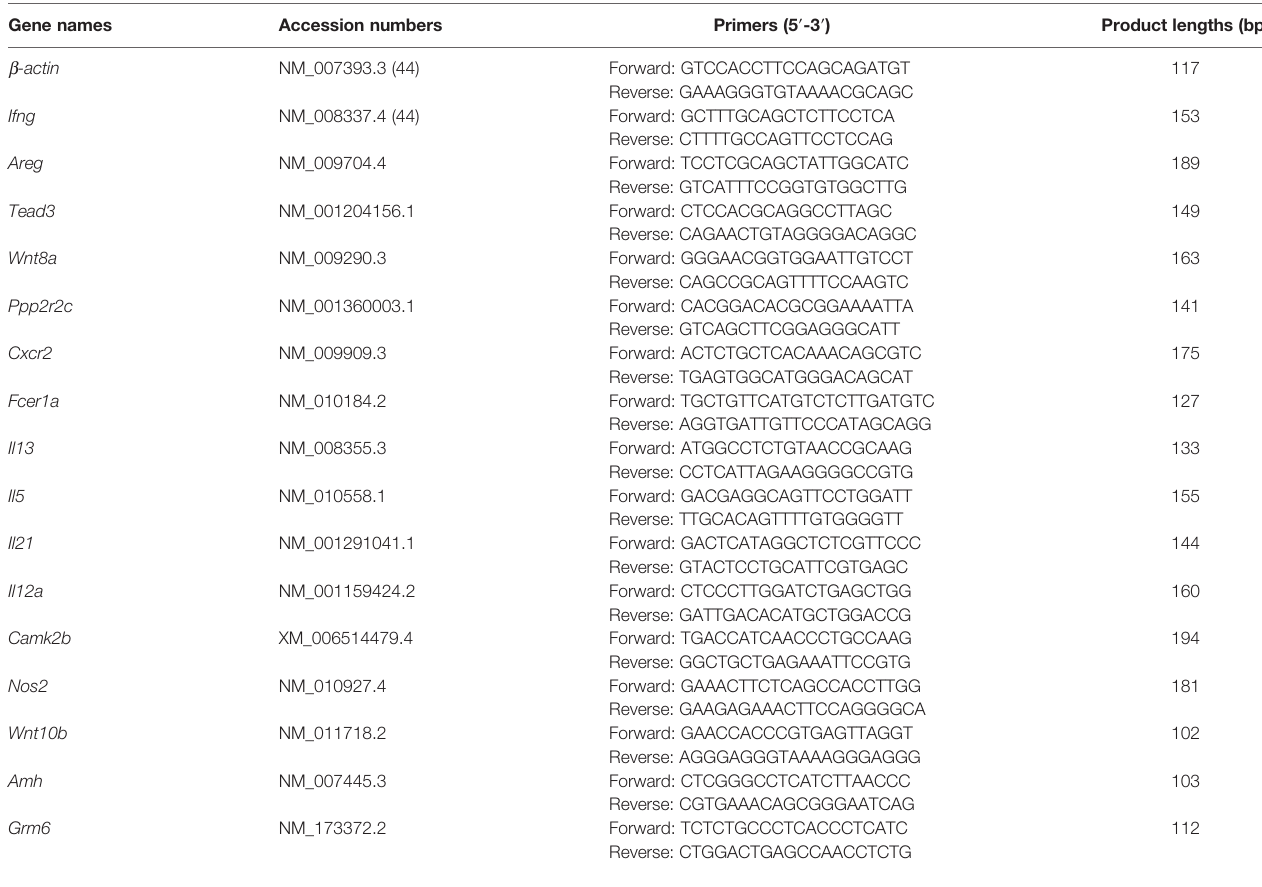
TABLE 1 | Primers used for qRT-PCR